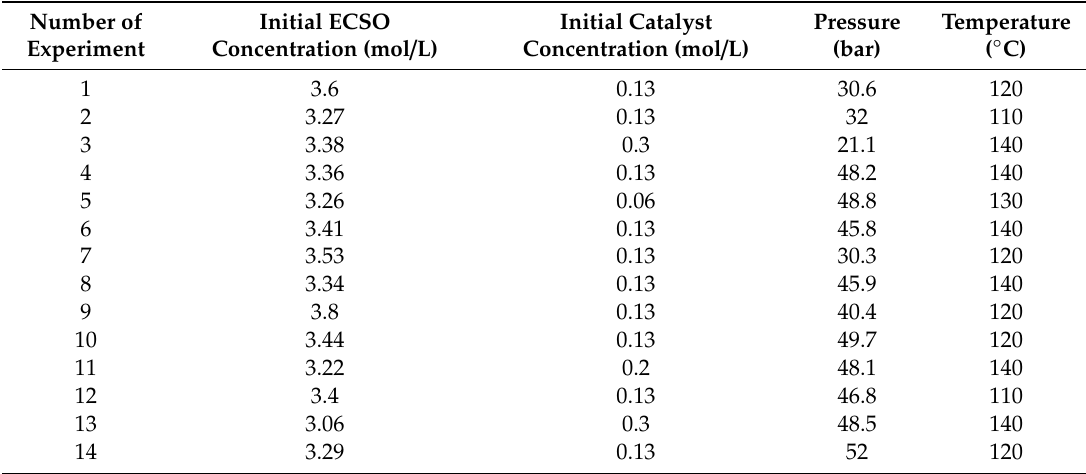
Table 1. The experiments considered for this study (only the cases where epoxidized cottonseed oil (ECSO) was present initially were